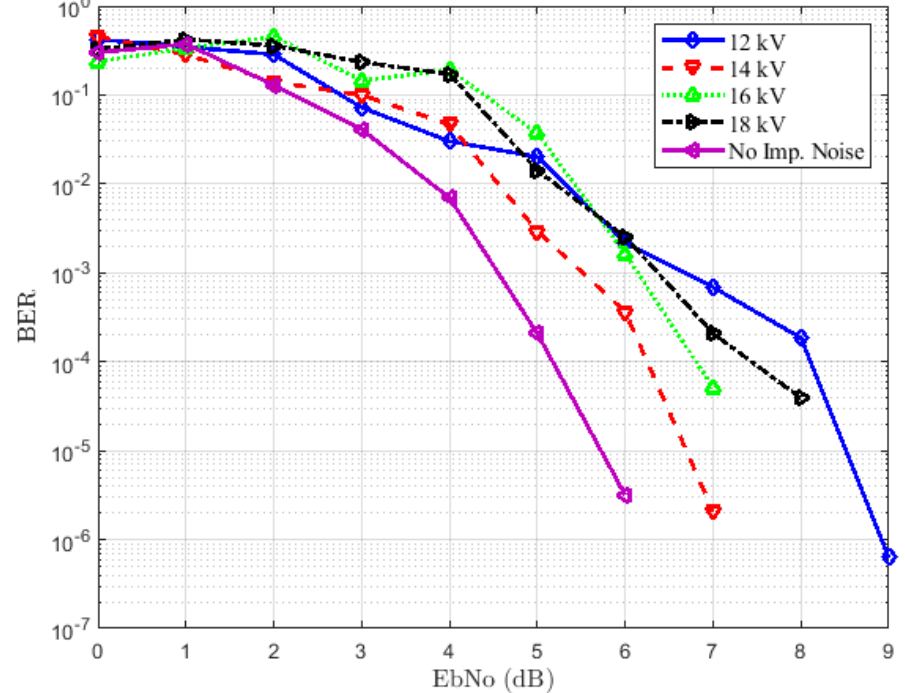
Figure 9. BER performance for different voltages in the NLOS situation.